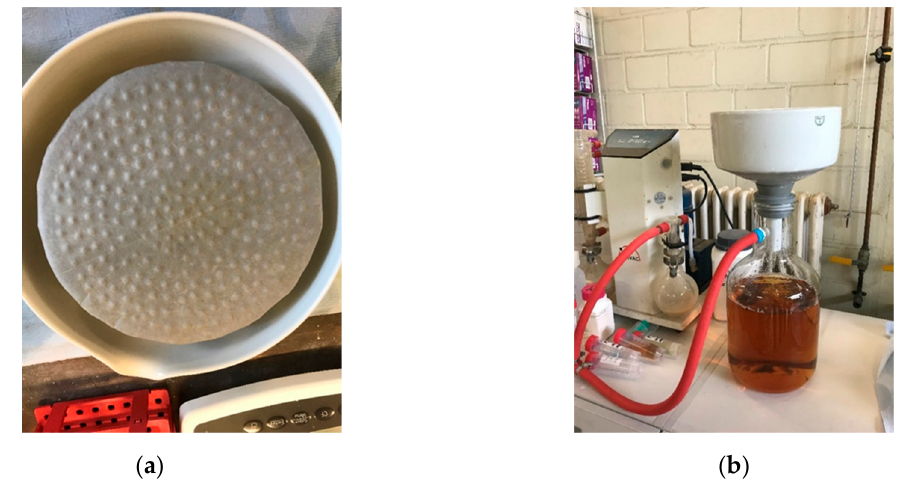
Figure 4. ( a ) Filter cake and ( b ) obtained solution during carbonation.